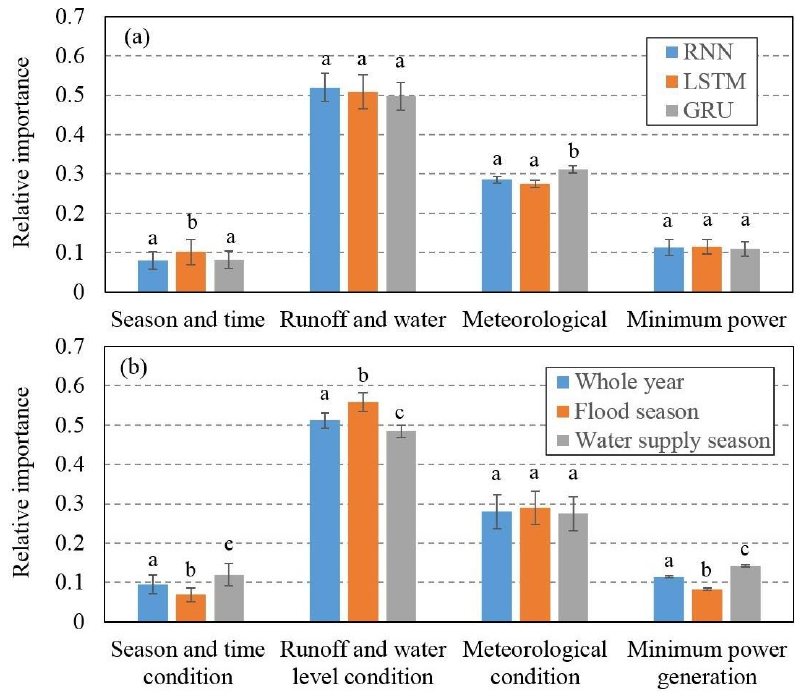
Figure 13. Relative importance of the input variables under different algorithm ( a ) and different operating season ( b ).